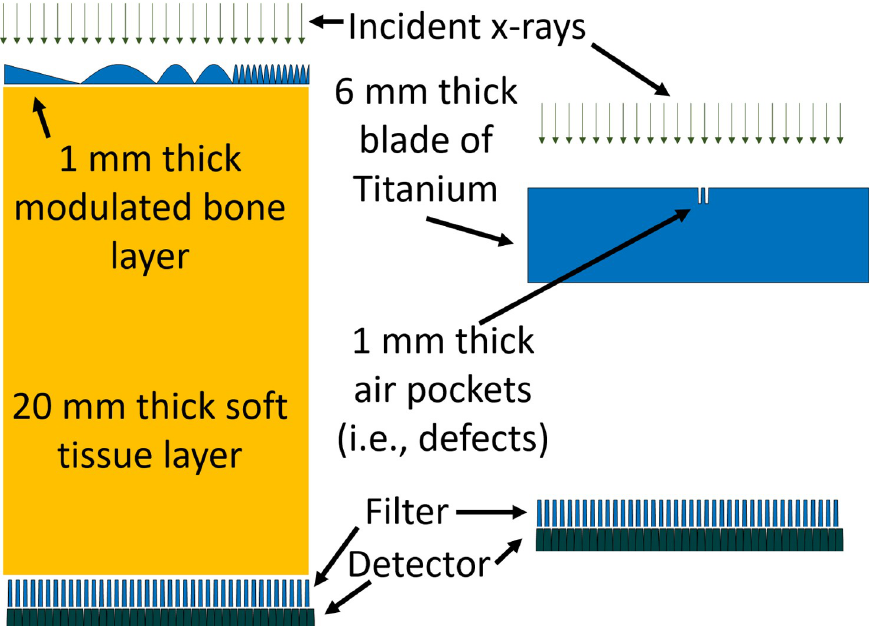
Fig 2. The medical and industrial simulation examples are shown on the left and right of this figure respectively. Figure not drawn to scale.